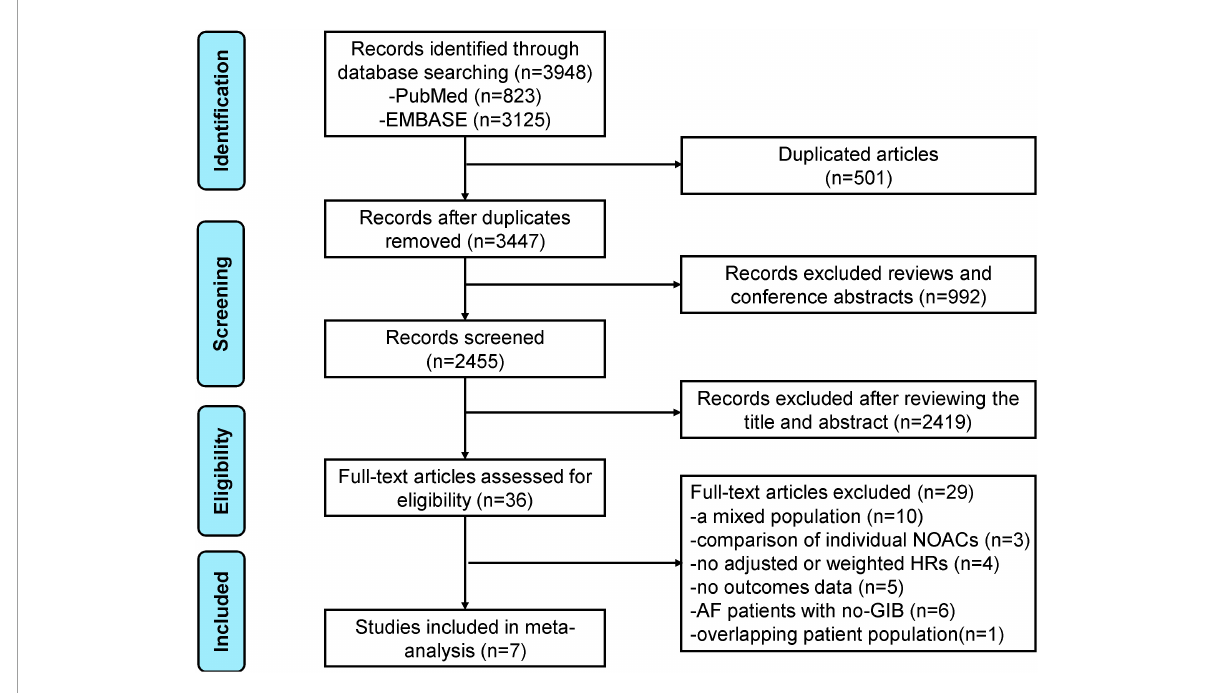
FIGURE1 The preferred reporting items for systematic review and meta-analysis (PRISMA) flowchart of this